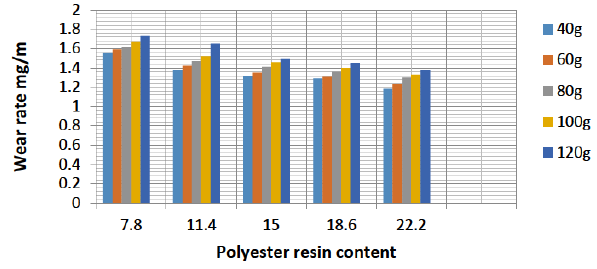
Figure 11: Wear rate of CNS /Polyester 250 µ m at 50 ∘ C